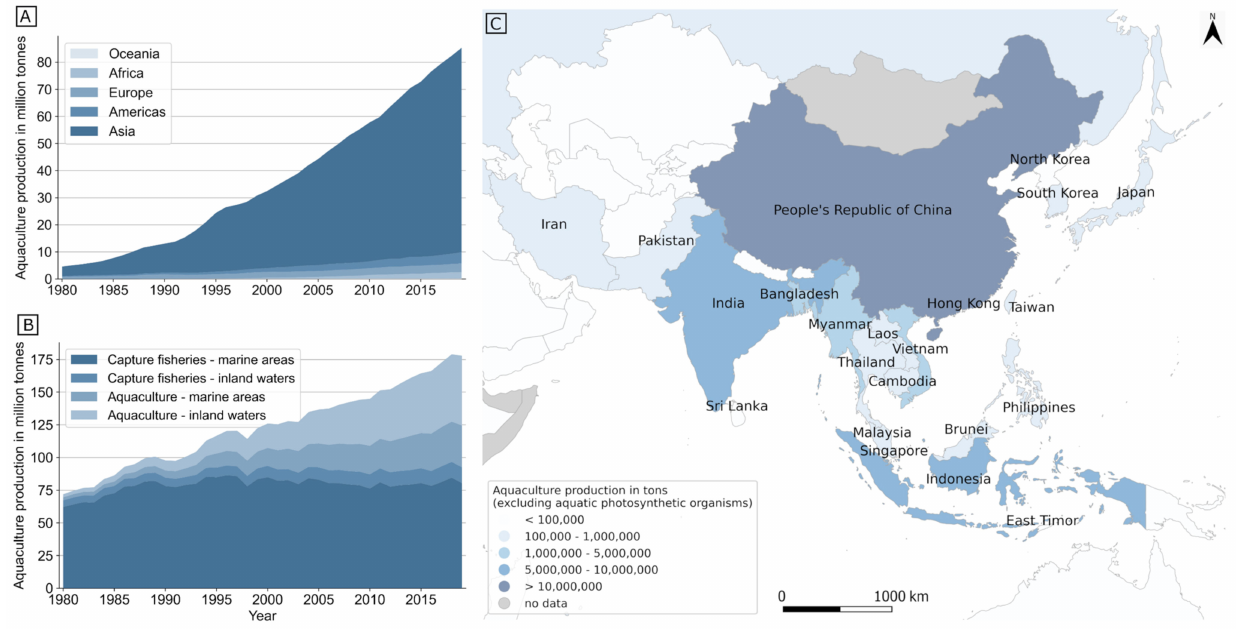
Figure 1. ( A ) Aquaculture production among continents from 1980–2019, ( B ) Global aquaculture production and capture fisheries production from 1980–2019, and ( C ) Map of aquaculture production in 2019. Data source: